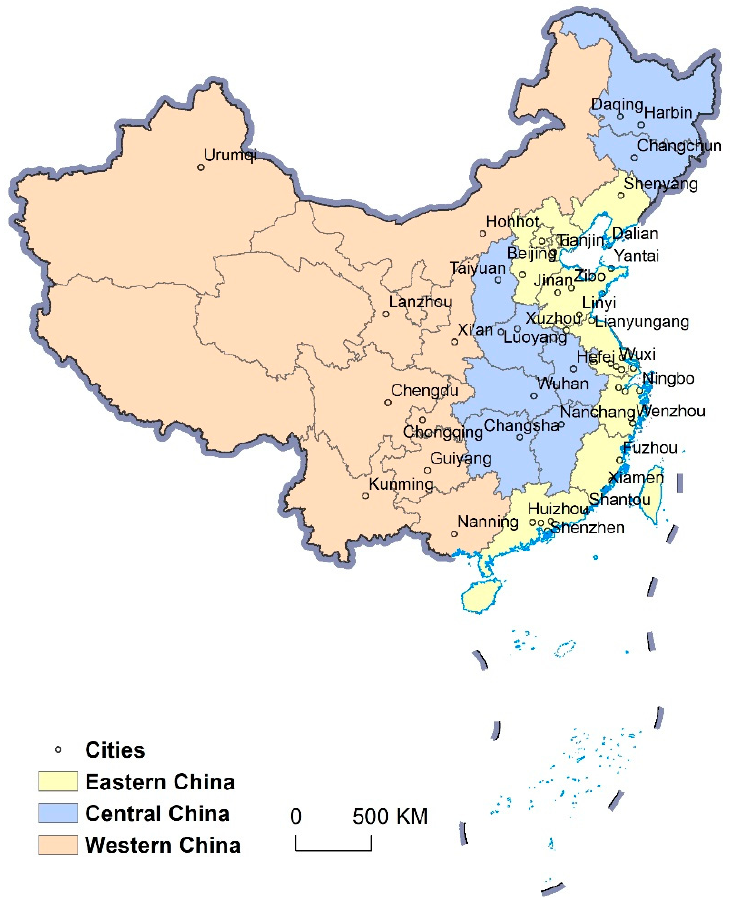
Figure 2. Locations of the 50 major cities in the three subregions of China. (Base on map sources: GS (2019)1651.) GS